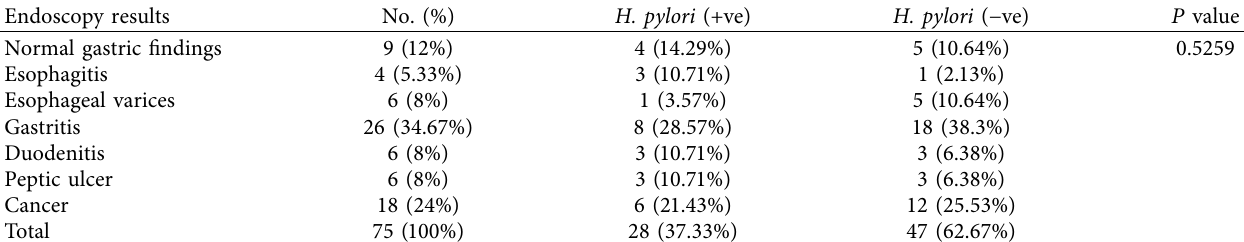
Table 2: Distribution of participants according to endoscopy series and status of H. pylori infection. Endoscopy results No. (%)